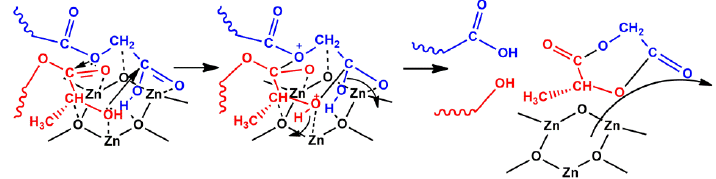
Figure 3. Depolymerization of GAO and LAO on the surface of ZnO.